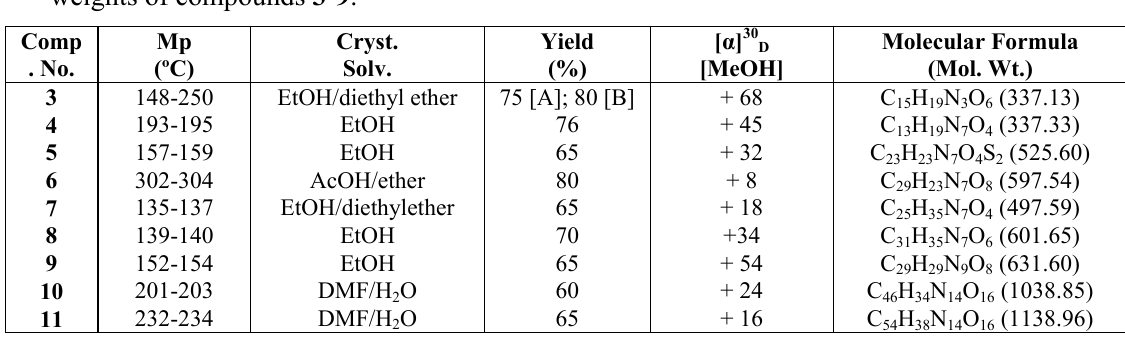
Table 1. Melting points, crystallization solvents, yields, molecular formulae and molecular weights of compounds 3-9